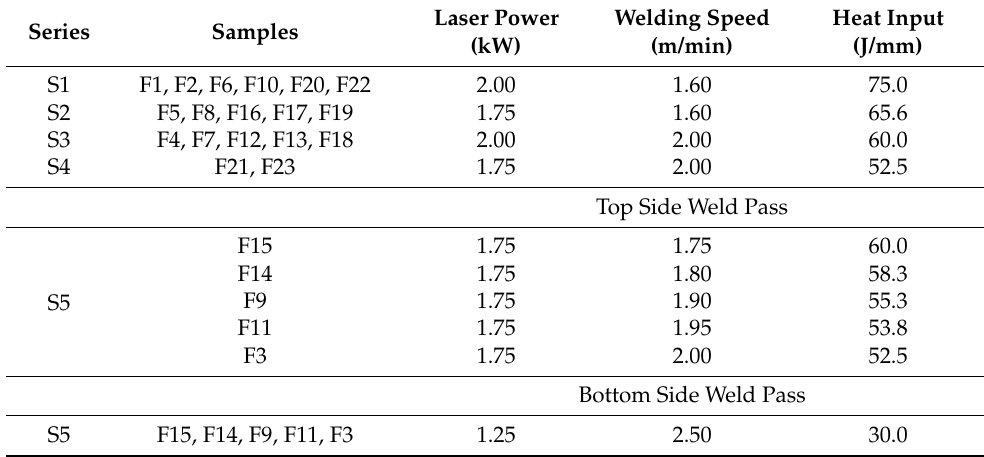
Table 3. Welding parameters used in the experimental